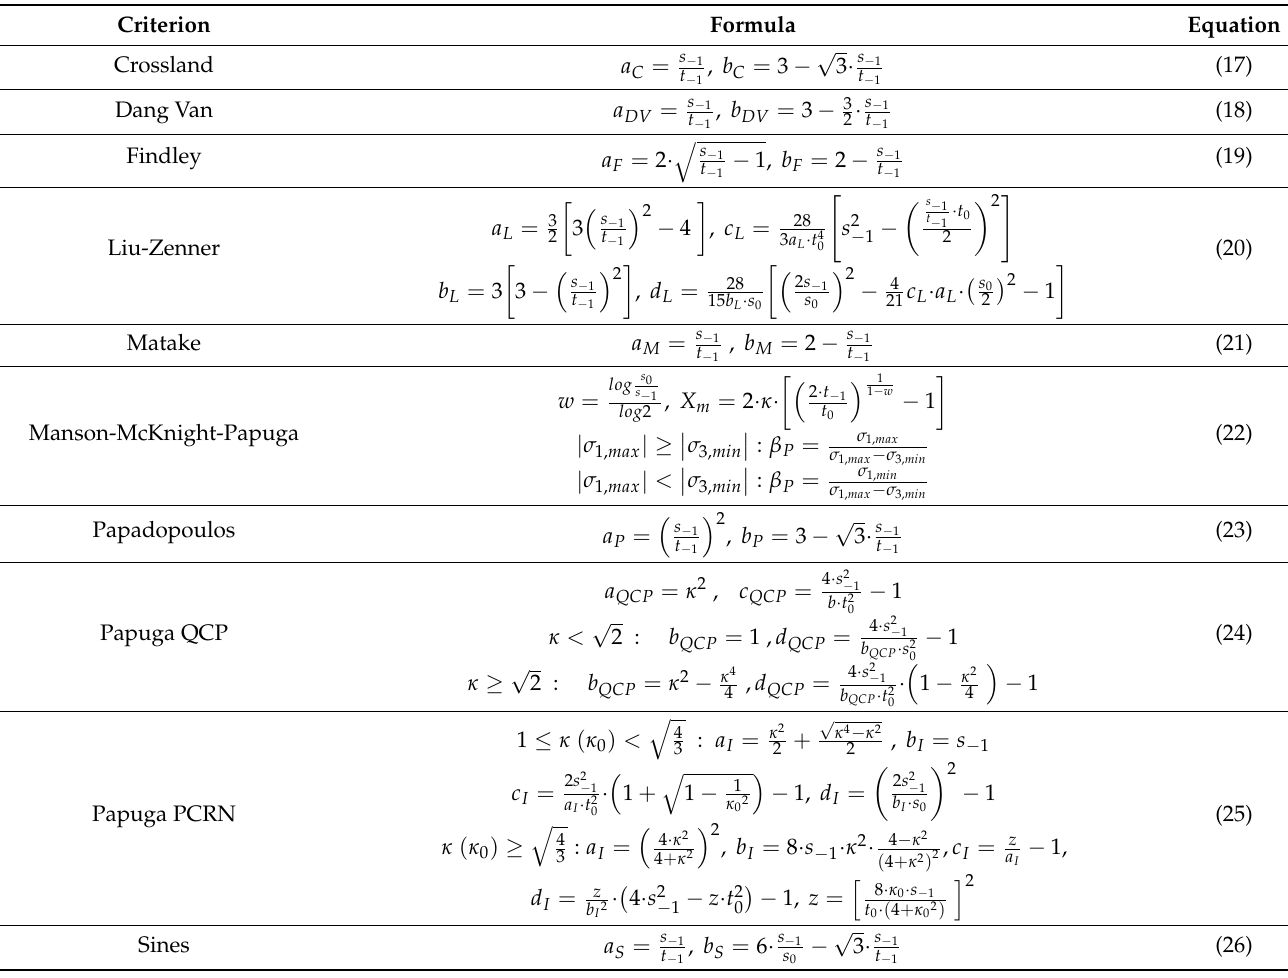
Table 7. Material parameters of individual criteria and their limitations. s − 1 —fatigue strength in fully reversed axial loading, t − 1 —fatigue strength in fully reversed torsion, t 0 —fatigue strength in repeated torsion (maximum stress of the cycle), s 0 —fatigue strength in repeated axial loading (maximum stress of the cycle), σ 1 is maximum principal stress, σ 3 is minimum principal stress, κ is ratio of fatigue strengths in fully reversed loadings ( s − 1 / t − 1 ), κ 0 is ratio of fatigue strengths in repeated loadings ( s 0 / t 0